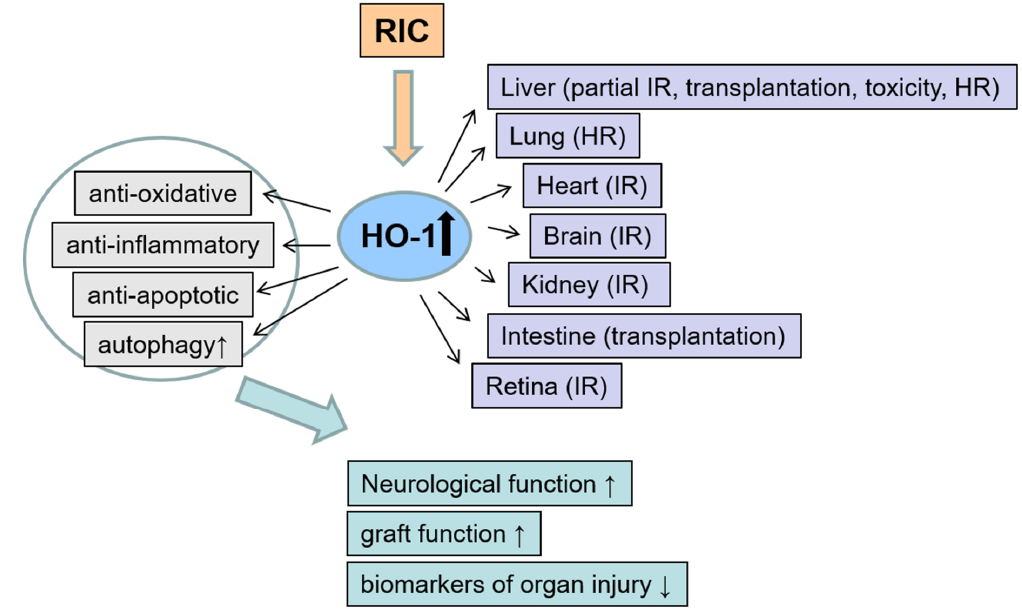
Figure 3. Protective effects of remote ischemic conditioning (RIC). Organs and stress models (purple); mechanisms (grey); and e ff ects on organ injury and function. RIC: remote ischemic conditioning; HO: mechanisms (grey); and effects on organ injury and function. RIC: remote ischemic conditioning; HO: heme oxygenase; IR: ischemia / reperfusion; HR: hemorrhagic shock with heme oxygenase; IR: ischemia/reperfusion; HR: hemorrhagic shock with resuscitation.